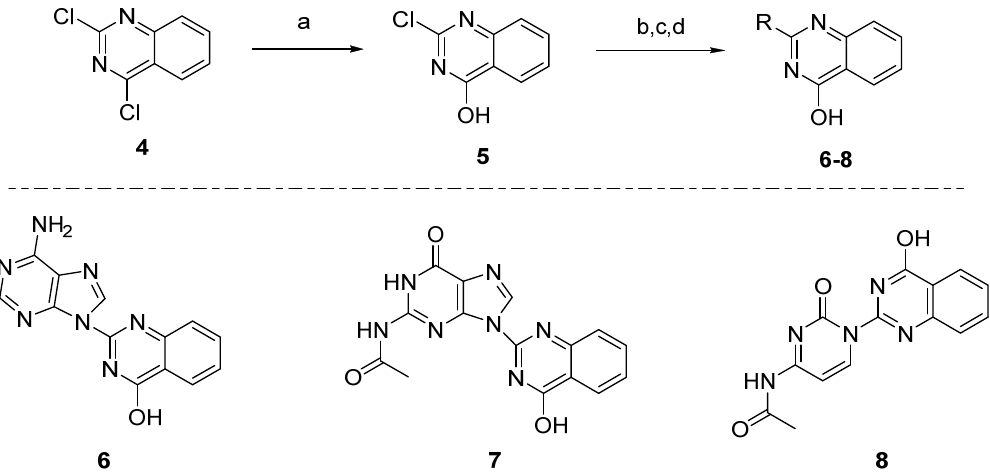
Figure 4. Synthesis of nucleoside analogues 6 – 8 . Reagents and conditions: (a) sodium hydroxide solution (2% NaOH), r.t. 4 h, (b) for compound 6 , adenine, cesium carbonate (Cs 2 CO 3 ), silica gel, inert atmosphere, 130 °C, 3.5 h, (c) for compound 7 , N -acetyl guanine, cesium carbonate (Cs 2 CO 3 ), silica gel, inert atmosphere, 130 °C, 24 h, (d) for compound 8 , N -acetyl cytosine, cesium carbonate (Cs 2 CO 3 ), silica gel, inert atmosphere, 130 °C, 24 h.